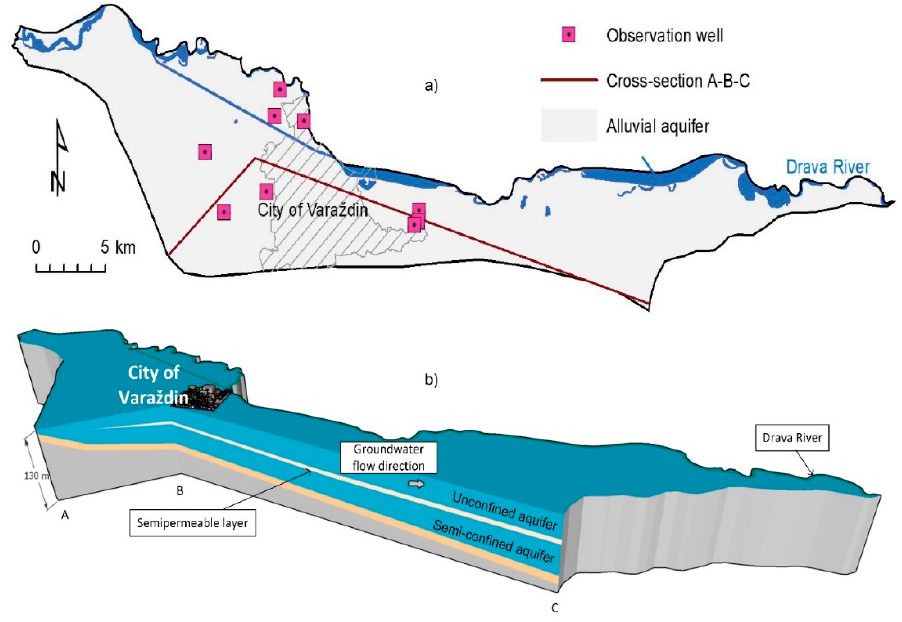
Figure 2. Conceptual model of the groundwater body CDGI_19: ( a ) Planar extent of the groundwater body; ( b ) Schematic 3D hydrogeological cross-section.